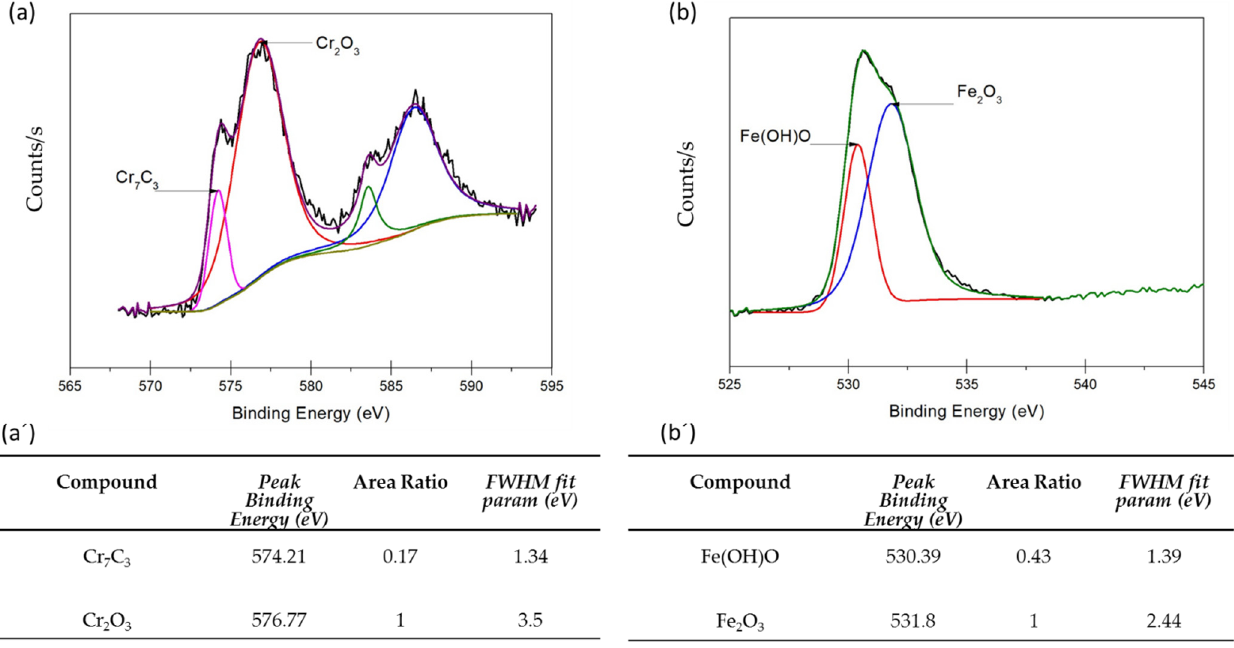
Figure 8. X-ray photoelectron spectra for AM350CA–75 min–49 °C: ( a ) Cr 2p, ( b ) O 1s. Parameters obtained: peak binding energy and FWHM fit param ( a’ ) Cr 2p, ( b’ ) O 1s.